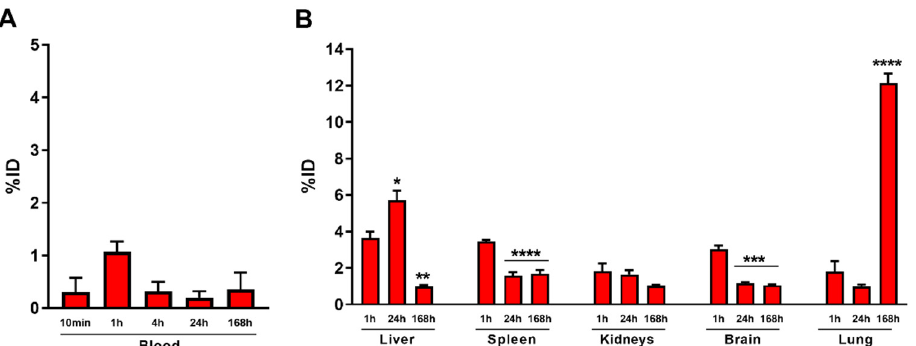
Figure 3. Titanium content in organs. Elemental titanium in ( A ) blood, ( B ) liver, spleen, kidneys, brain, and lungs of mice intravenously treated with 6 mg/kg b.w. E171. Ti content was determined using inductively coupled plasma mass spectrometry (ICP-MS) on tissues collected at different times after the E171 treatment. Data are given as percentages of the injected dose (% ID). Each data point represents the mean ± SEM (N = 3); * p < 0.05, ** p < 0.005, *** p < 0.0005, and **** p < 0.0001 vs. 1 h, according to one-way ANOVA and Bonferroni post hoc tests.